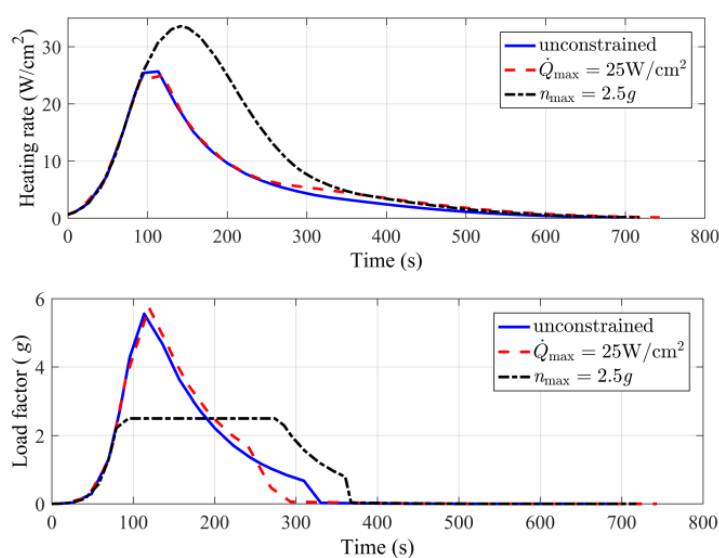
Figure 6. Heating rate and load factor profiles with different path constraints.